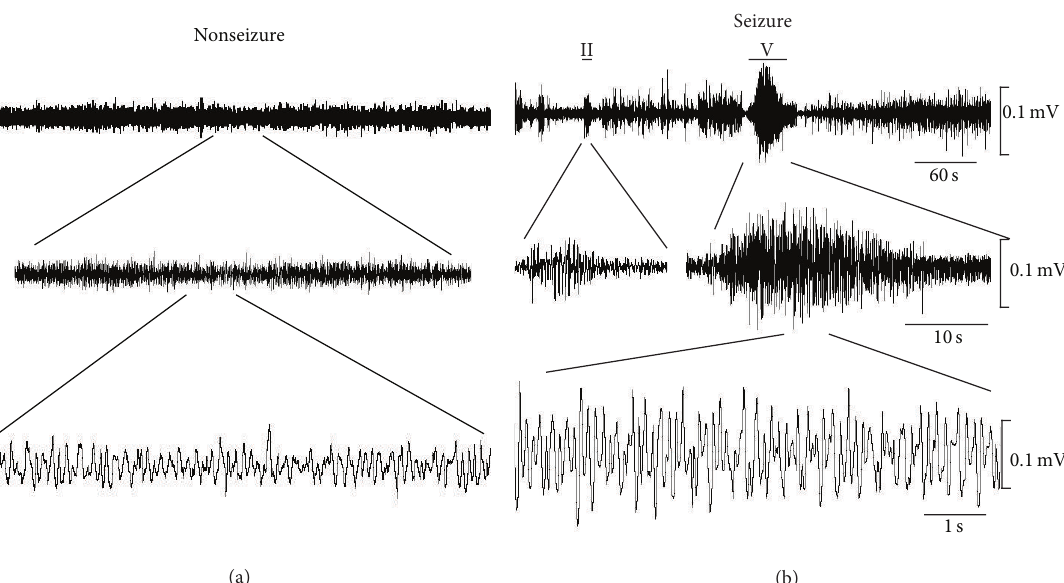
Figure 2: Epileptic EEG recorded in the chronic phase of a CTZ induced seizure rat. Raw EEG recording traces showing (a) normal EEG waveform during nonseizure period and (b) high amplitude high frequency interictal and ictal like epileptic EEG associated with the seizure behavior (marked with bars above the EEG traces) from CTZ induced seizure rats at the time of 6 months after initial seizure induction by